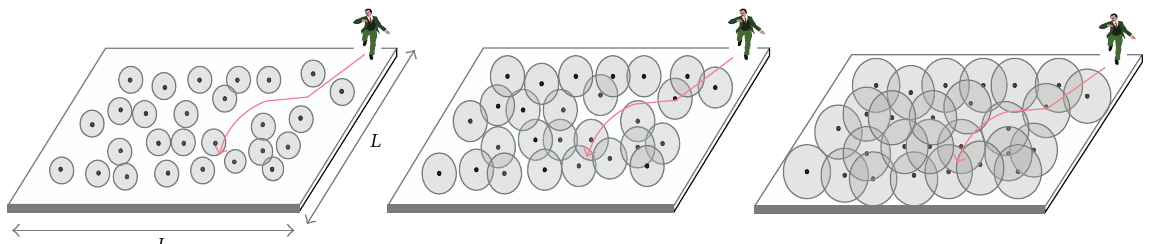
Figure 2: A typical network generated via uniform distribution of the 𝑥 , 𝑦 coordinates of the sensor nodes. The sensing ranges of the node are increased gradually (from left to